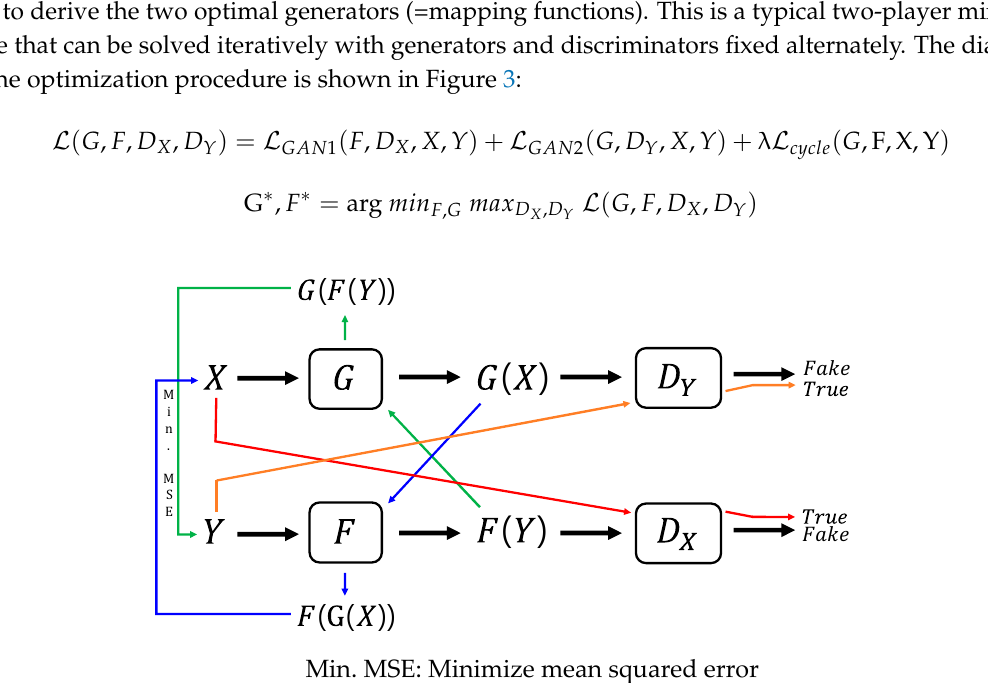
Figure 3. Optimization procedure for the CycleGAN .